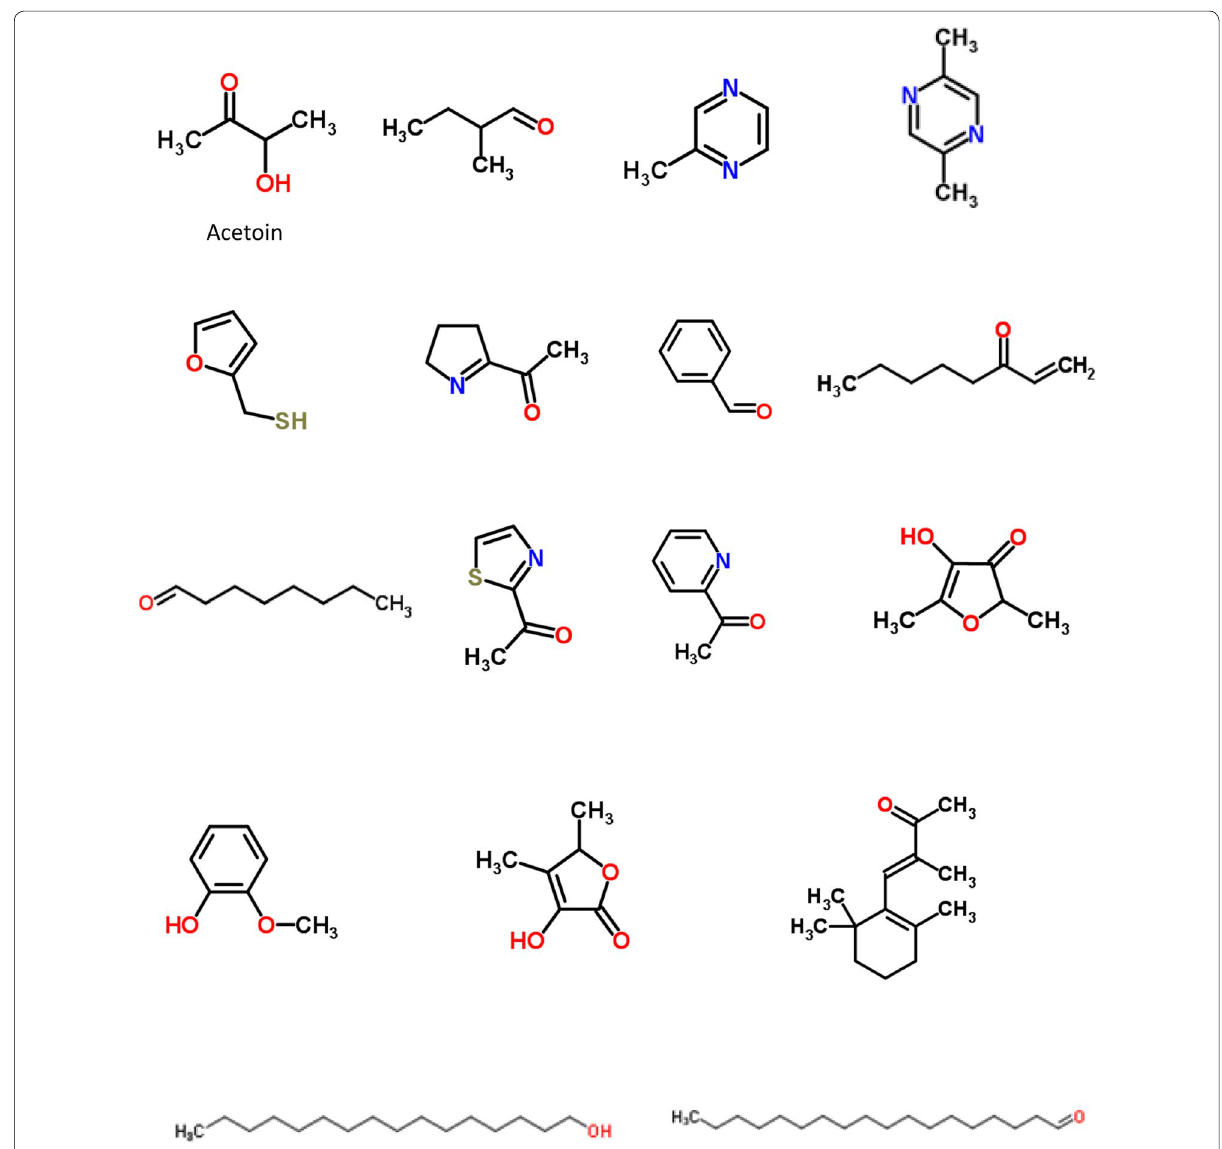
Fig. 2 Aroma-active compounds in boiled and fried African giant snail